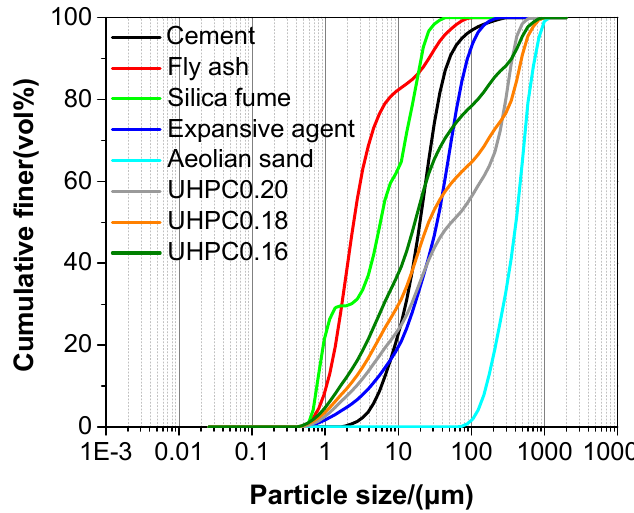
Figure 1. The particle size distribution of the raw materials.